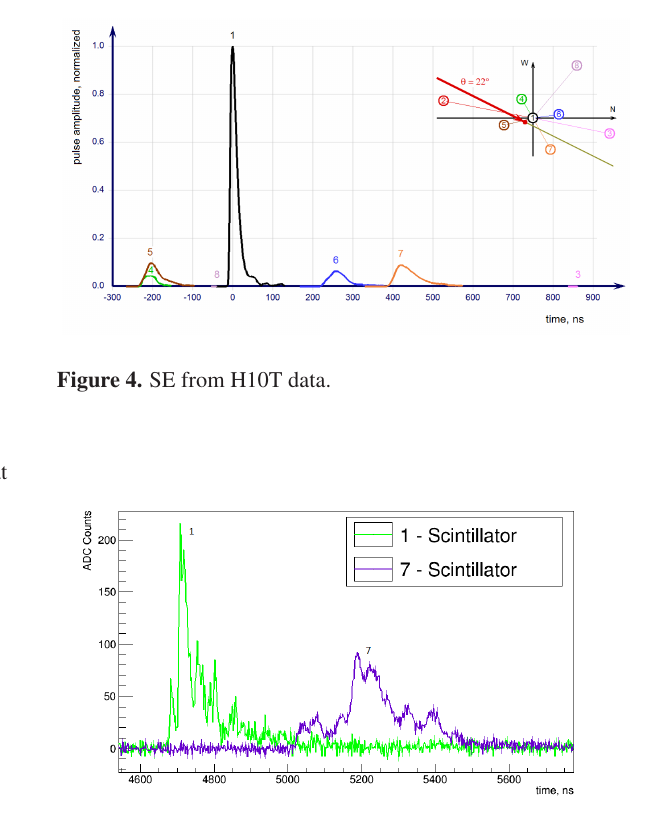
Figure 5. Unusual event from HT data.